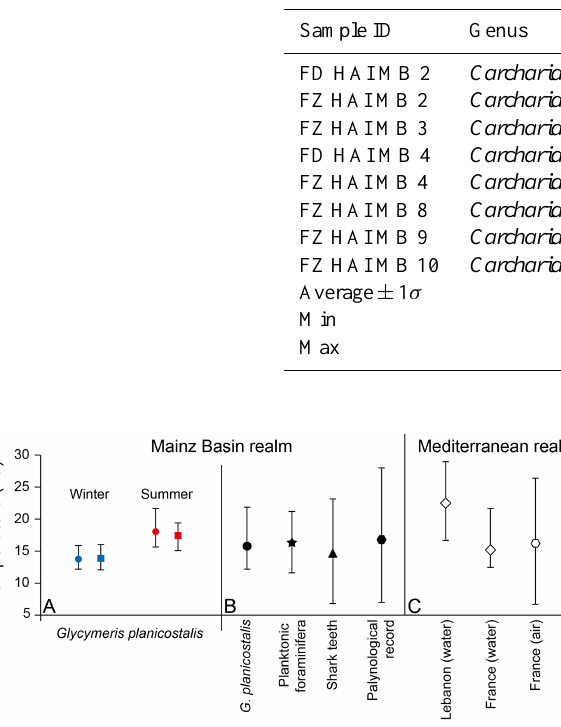
Figure 6. Seasonal temperature ranges and averages. (a) Compari- son between raw (circles) and mathematically re-sampled (squares) summer (red) and winter (blue) temperature data based on shell oxygen isotope data of three fossil Glycymeris planicostalis shells. Whereas mathematical re-sampling did not greatly affect average values and winter ranges, the summer temperature range of re- sampled data is truncated. (b) Comparison of the reconstructed tem- perature data based on δ 18 O shell values of the three studied bi- valve shells (solid black circle) and previously published temper- ature data based on planktonic foraminifera (Grimm, 1994), shark teeth (Tütken, 2003) and palynological associations (Pross et al., 2000). (c) Seawater temperatures off Lebanon and southern France at 35m depth (Abboud-Abi Saab et al., 2004) and air tempera- tures in southern France (Global Historical Climatology Network (GHCN) Monthly Dataset; Lawrimore et al.,